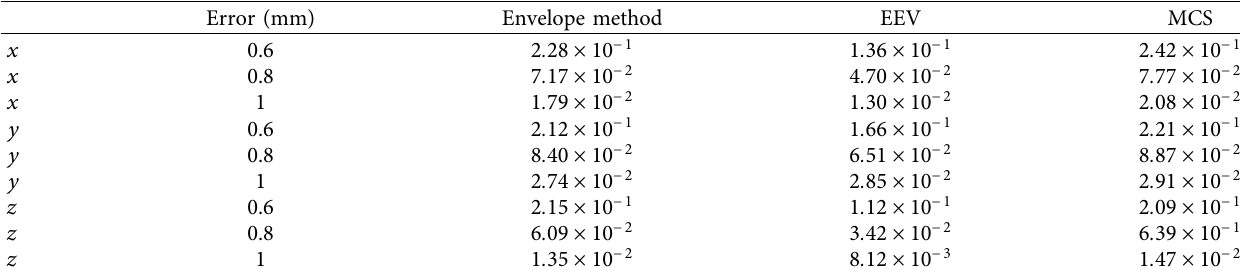
Figure 8: Reliability of the robot position. (a) Failure probability in the x direction. (b) Failure probability in the y direction, and (c) Failure probability in the z direction. Table 3: Reliability of the